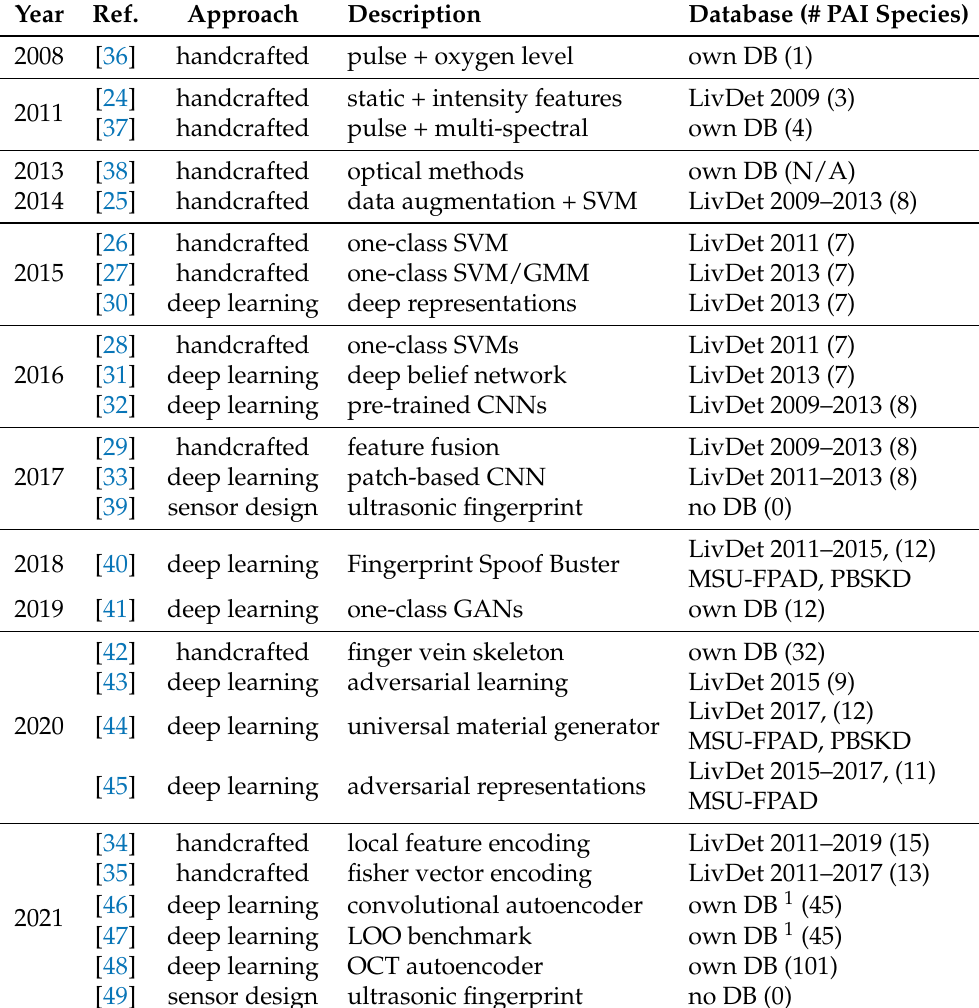
Table 1. A summary of related fingerprint PAD